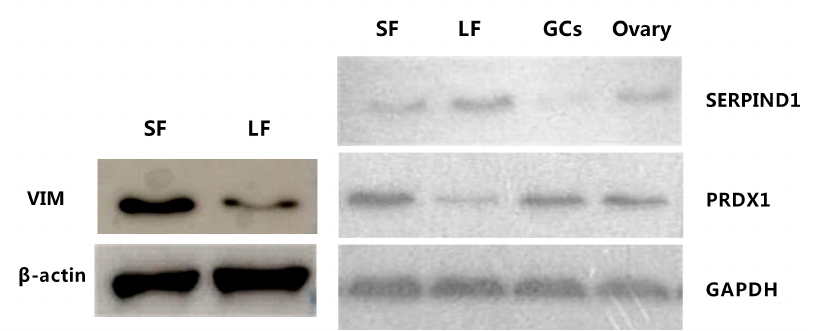
Figure 5. Western blot analysis of the protein expression levels in BFF. SF: <4-mm diameter follicles; LF: >8-mm diameter follicles; GCs: granulosa cells.